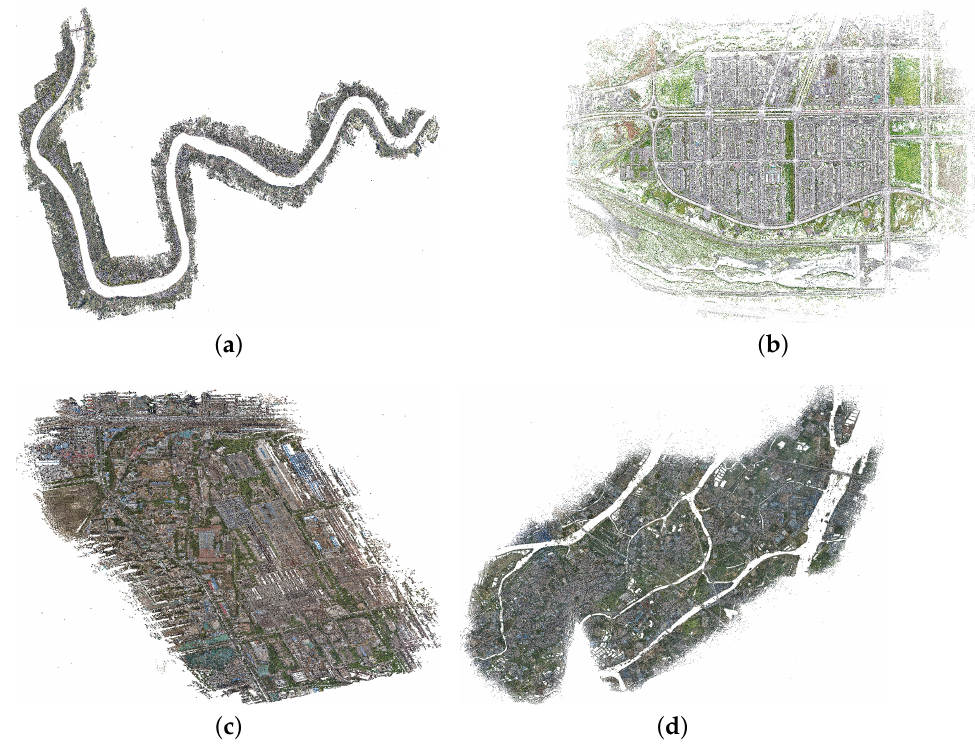
Figure 18. Image points cloud of the experimental dataset. ( a ) Dataset 1. ( b ) Dataset 2. ( c ) Dataset 3. ( d ) Dataset